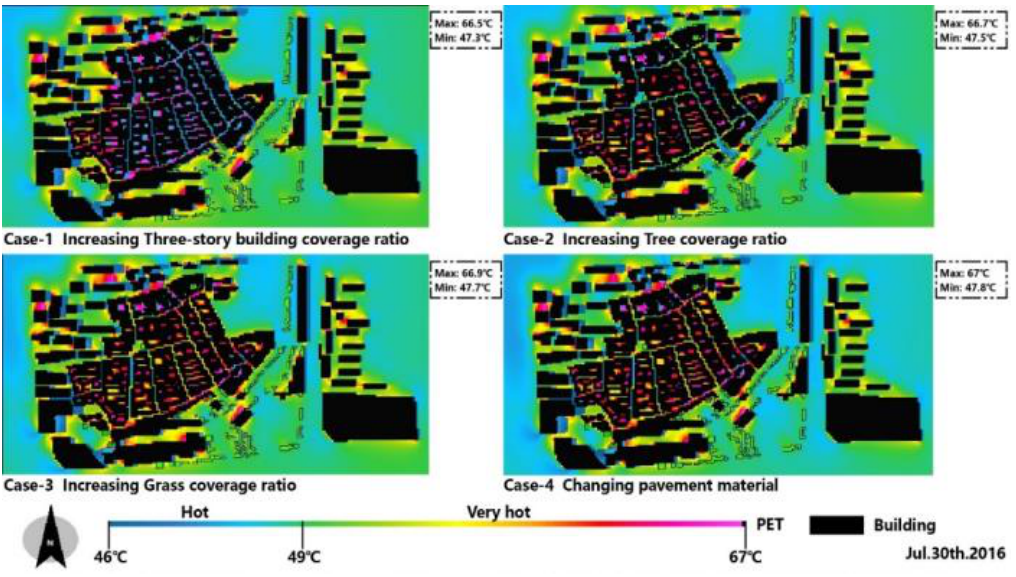
Figure 15. New PET distribution in different cases at 3:00 pm in the first measured day.